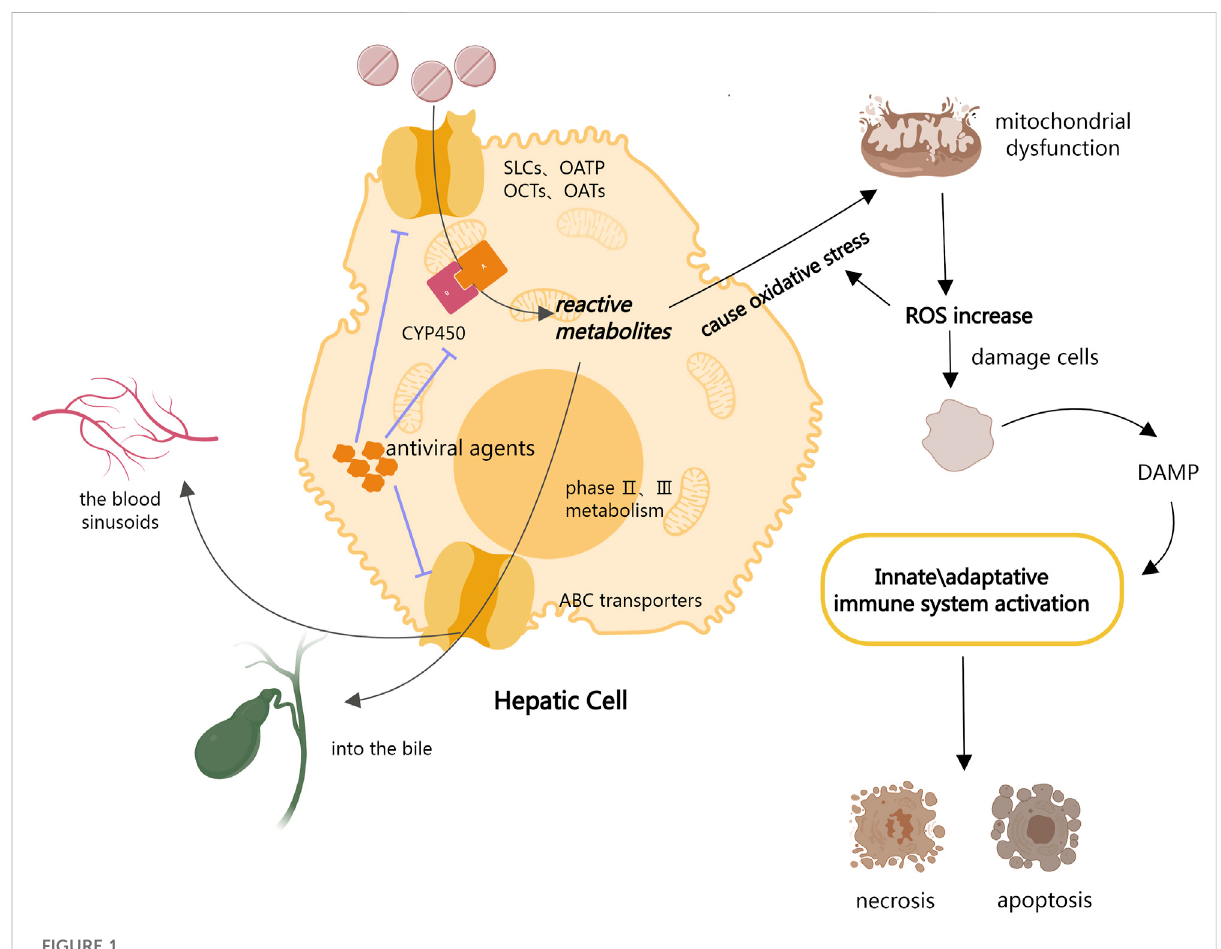
FIGURE 1 Metabolism of antiviral drugs in hepatocytes leads to DILI.